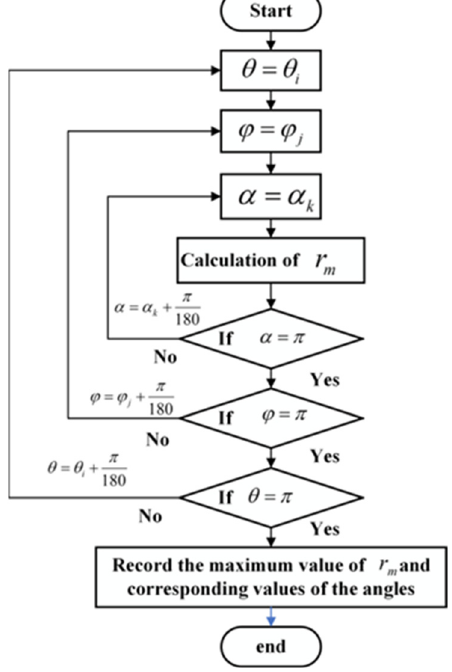
Figure 2. The working principle of the coordinate transform method.